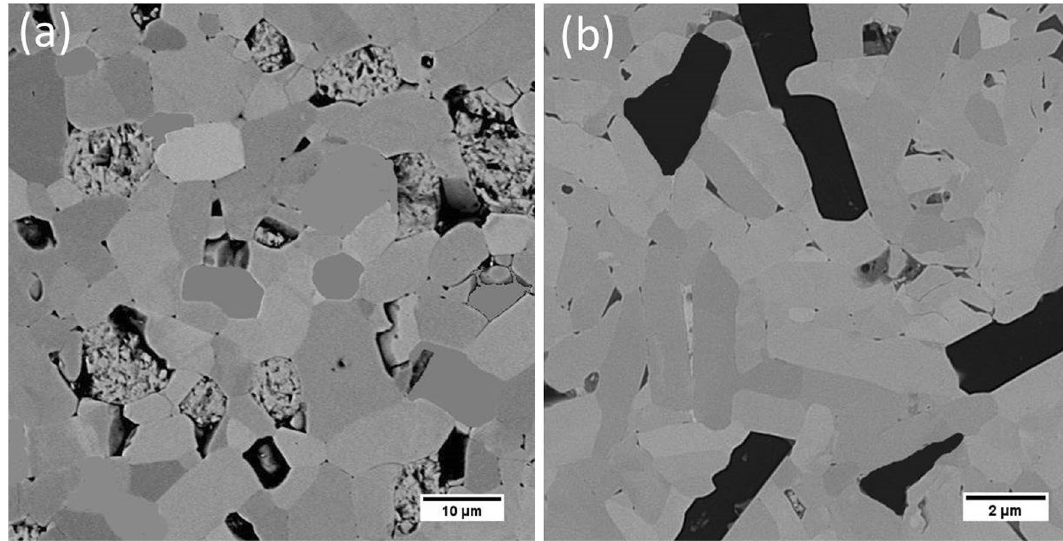
Figure 5. FESEM micrographs of ( a ) Hf0 and ( b ) Hf25. Showing reduction of HfB 2 grain size by in situ formation of SiC reinforcement.